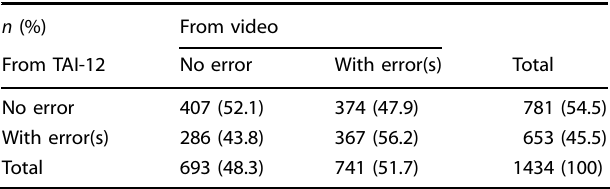
Table 3. Agreement between clinician reported inhalation errors (TAI- 12) and from video recording